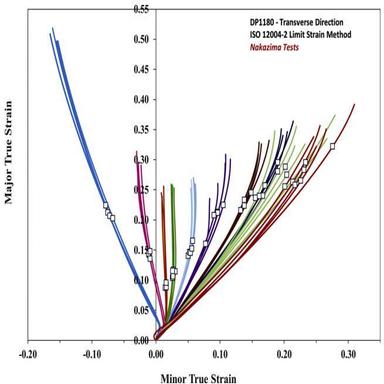
DP1180 limit strains and strain paths until the onset of fracture obtained using Nakazima tests. The symbols show the limit strains obtained by ISO 12004-2 method.